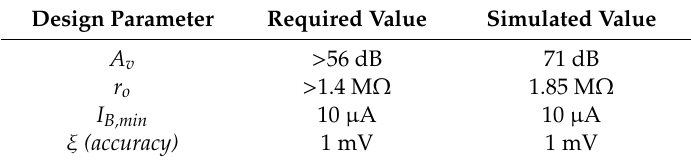
Table 2. Required and simulated design parameters for the open-loop switched-capacitor integrator. Design